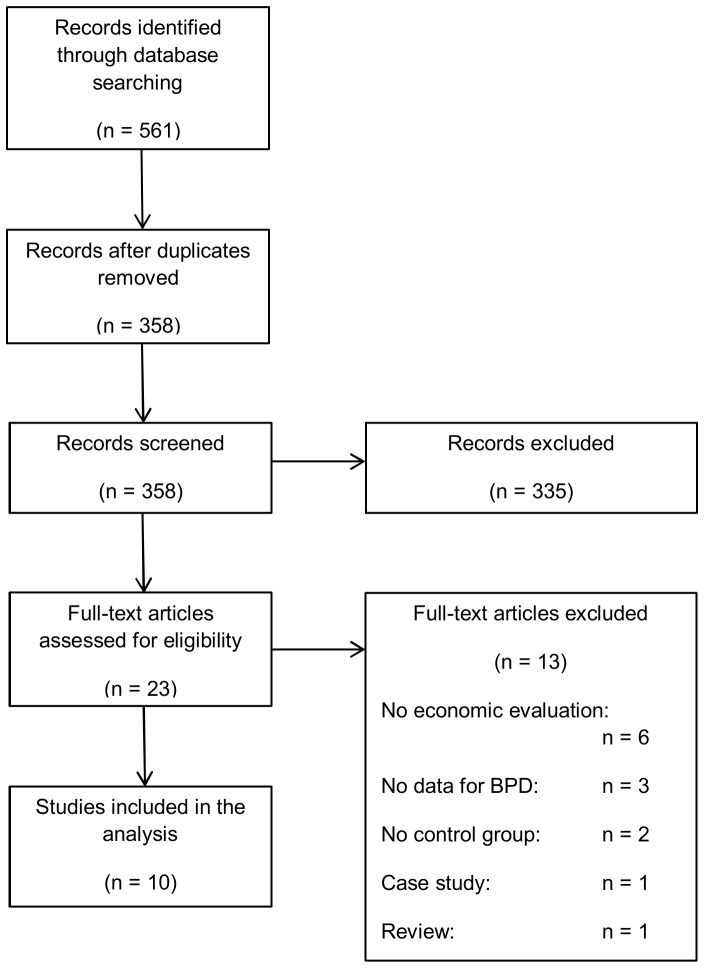
Prisma Flowchart.